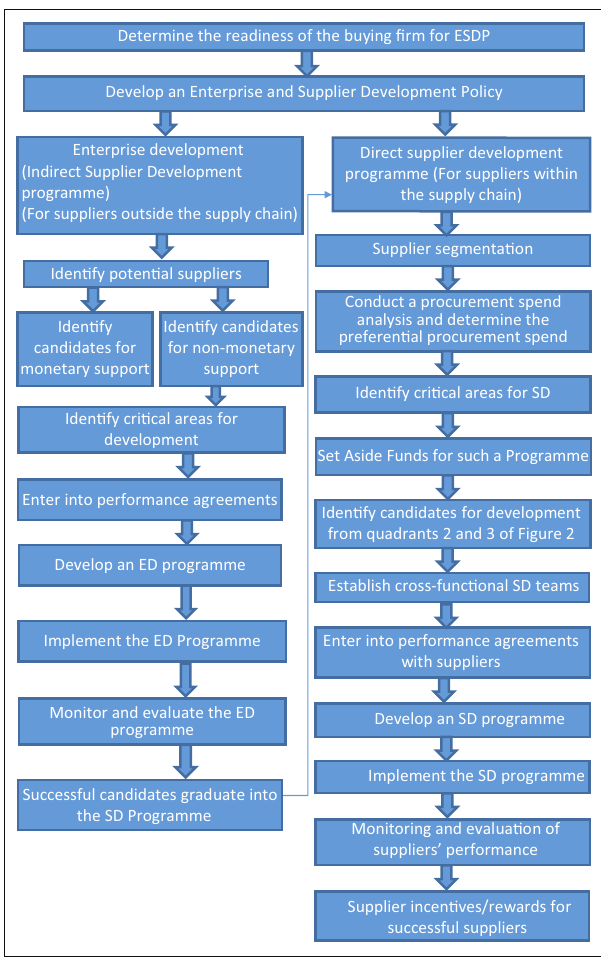
Monitor and evaluate the